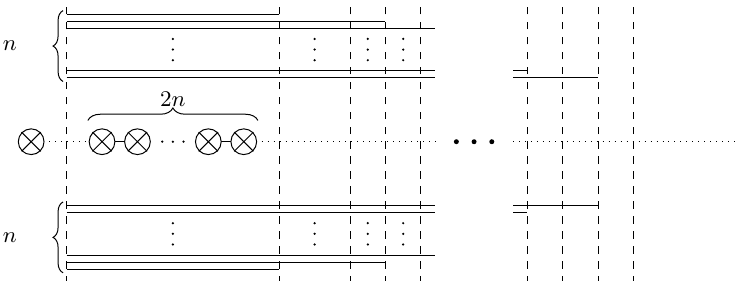
Figure 52. Higgs branch brane con(cid:12)guration for M H the closure of the maximal nilpotent orbit of sp ( n ). The leftmost interval between half D5-branes has n D3-branes. The number of D3-branes then decreases by one on each next pair of intervals to the right, until it reaches